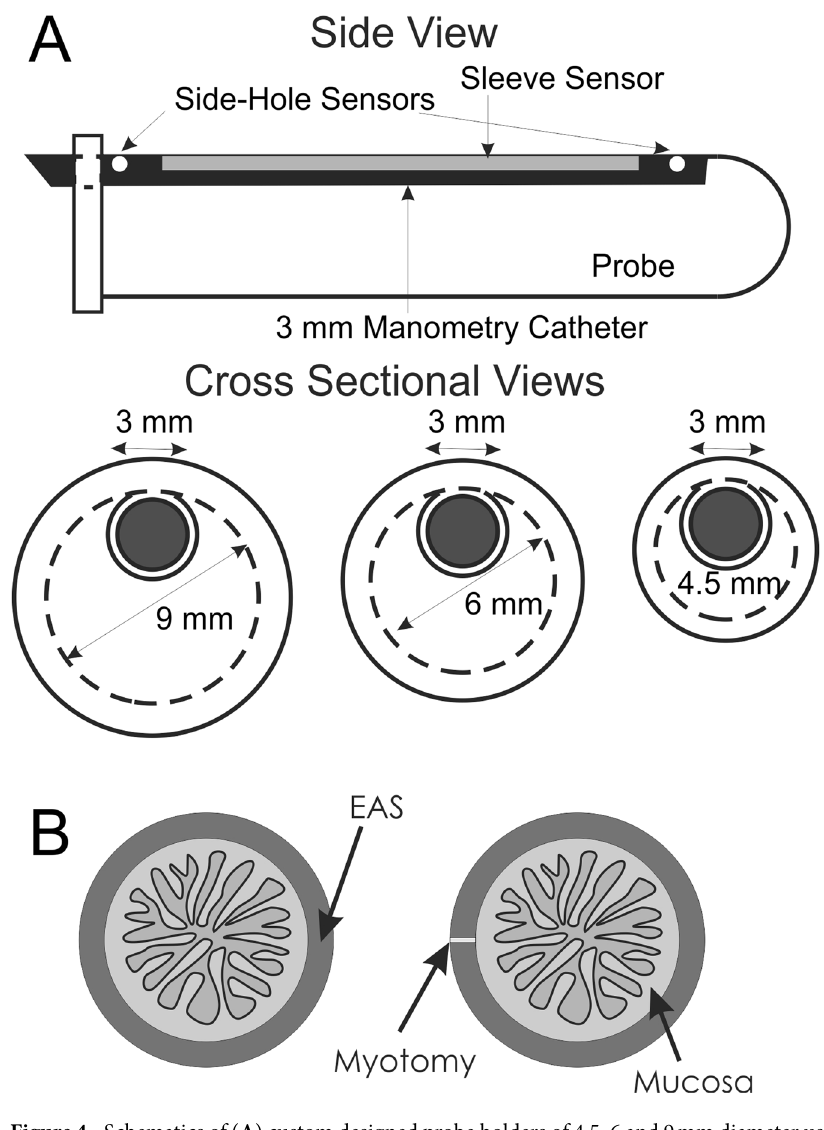
Figure 4. Schematics of ( A ) custom designed probe holders of 4.5, 6 and 9 mm diameter used in the EAS length-tension studies, and ( B ) schematic of rabbit external anal sphincter